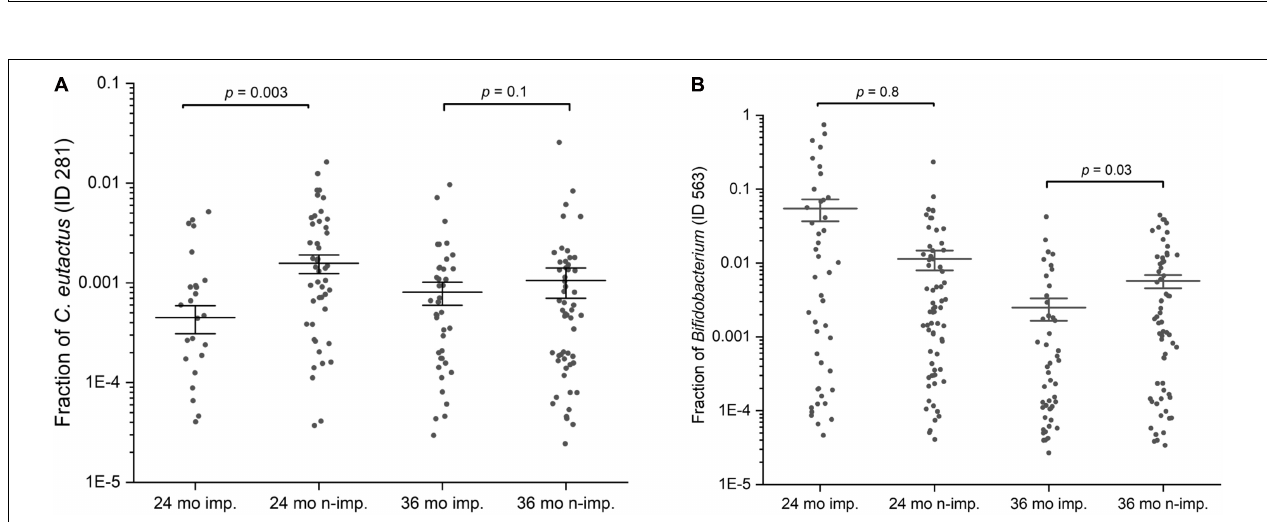
FIGURE 4 | Scatter interval plots of the fraction or relative abundance of C. eutactus and Bifidobacterium . (A) Fraction of Coprococcus eutactus (amplicon sequence variant ID 281) in the gut microbiota of 139 Ugandan children at the age of 24 and 36 months, (B) Fraction of Bifidobacterium longum group (amplicon sequence variant ID 563) in the gut microbiota of Uganda children aged 24 and 36 months. P -values were calculated with the two sided Mann–Whitney U test for language impaired ( n = 61) and language non-impaired groups ( n = 78) of the children.